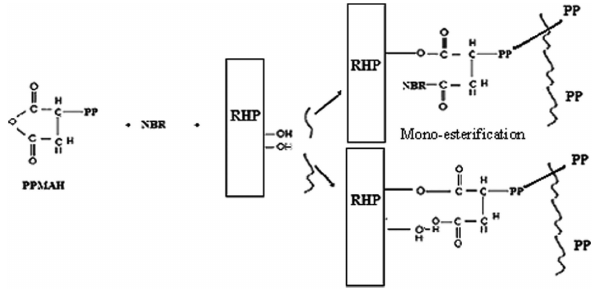
Figure 12: Proposed model of PPMAH compatibilization in PP/NBRr/RHP composites